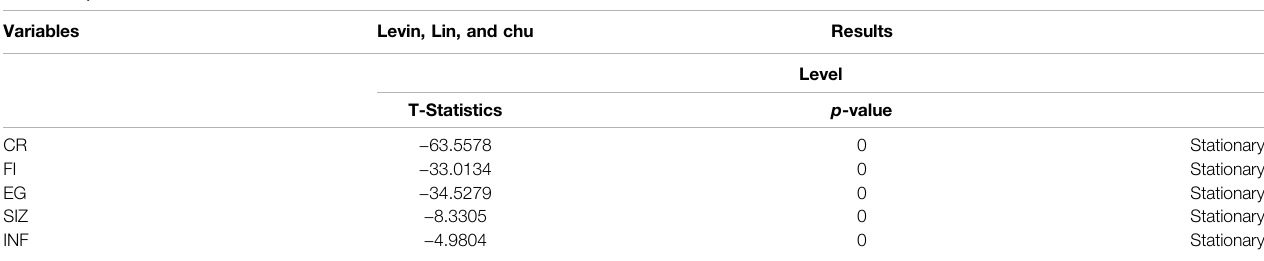
TABLE III | Panel unit root test results.